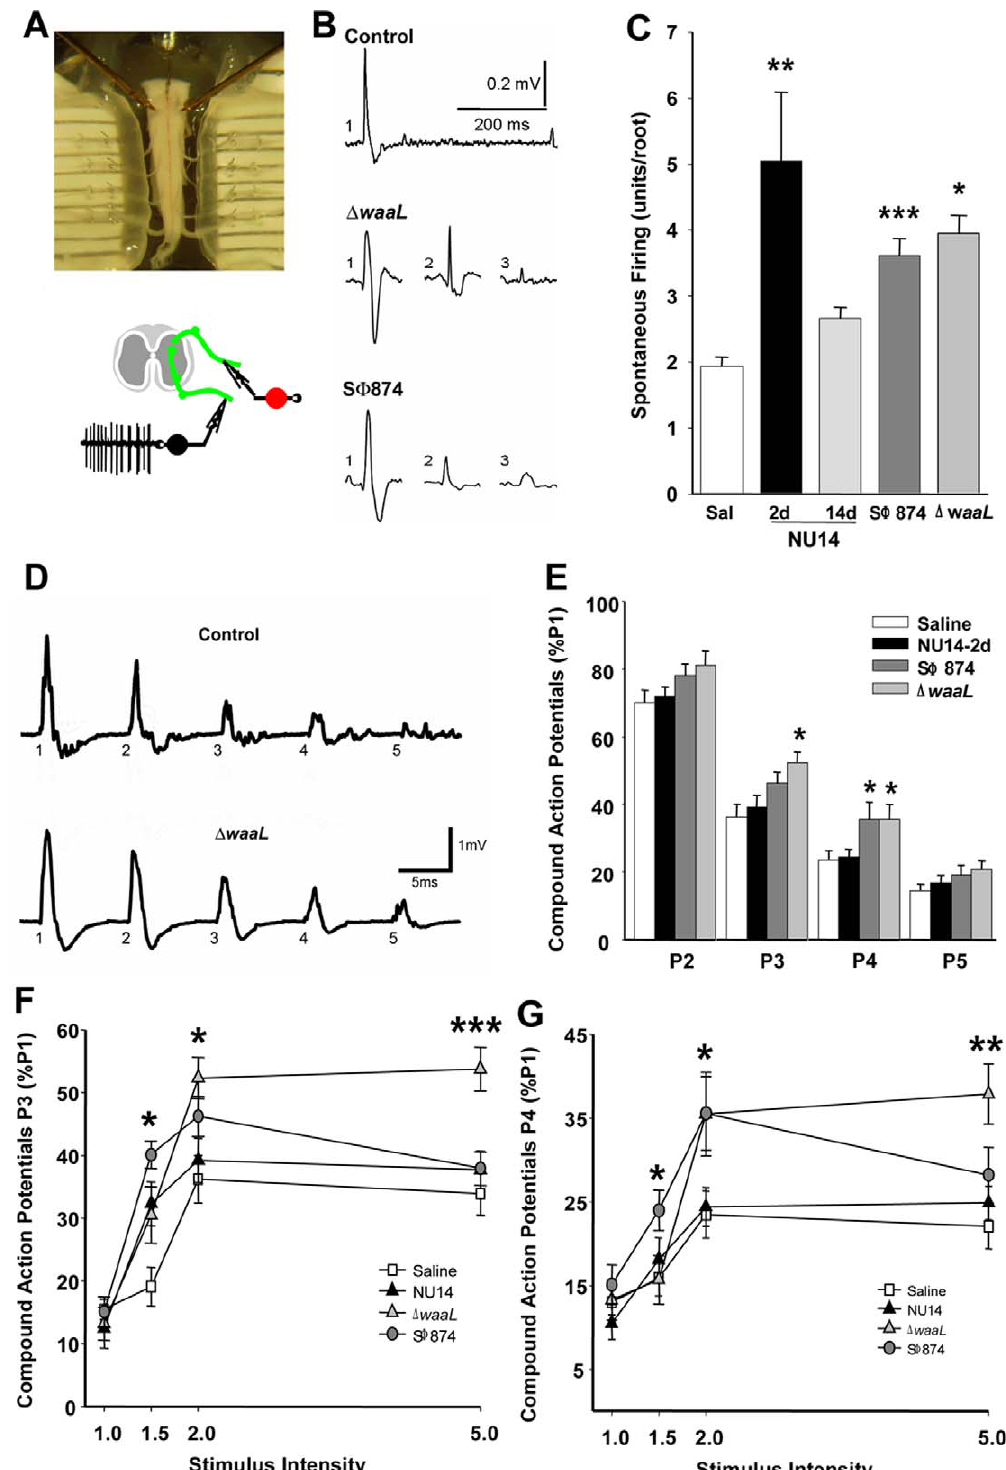
Figure 4. Pelvic pain behavior is associated with sacral spinal cord excitability. Spontaneous action potentials and evoked potentials were quantified in sacral spinal cords ex vivo at ventral roots S1–S3. ( A ) A sacral spinal cord is mounted in a recording chamber (upper panel), and spontaneous activity is recorded from the ventral root (lower panel). ( B ) Representative action potentials from spontaneous firing of individual neurons identified by pCLAMP. ( C ) Firing activity in sacral spinal cords is higher in D waaL at 14 d (n=5, P=0.0099), S W 874 at 20 days (n=9, P=0.0001), and NU14 mice at 2 d (n=6, P=0.0298) than in saline controls (n=7) or resolved NU14 (n=5). ( D ) Evoked ventral root responses to dorsal root current at 2 6 current intensity for spinal cord of saline mouse at 2 d (upper trace) and D waaL -infected mouse after serial infection. ( E ) Normalized responses at P2–P5 relative to P1 in ventral roots of mice instilled with saline (n=23), NU14 (n=26), S W 874 (n=21), or D waaL (n=12). *P , 0.05 and **P , 0.01 by Student t test relative to saline. ( F and G ) Responses across stimulus intensities at P3 and P4, respectively. doi:10.1371/journal.pone.0041273.g004 PLOS ONE | www.plosone.org